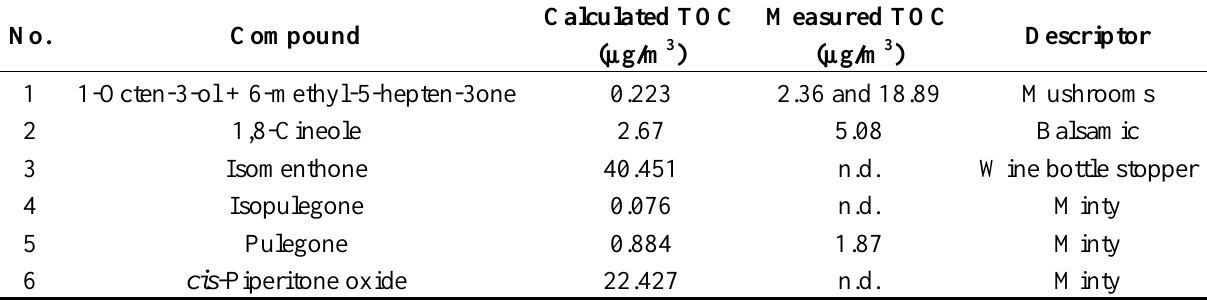
Table 2. TOC values calculated using AEDA method in GC-O technique and measured by dynamic dilution olfactometry (reprinted from [53] with permission from